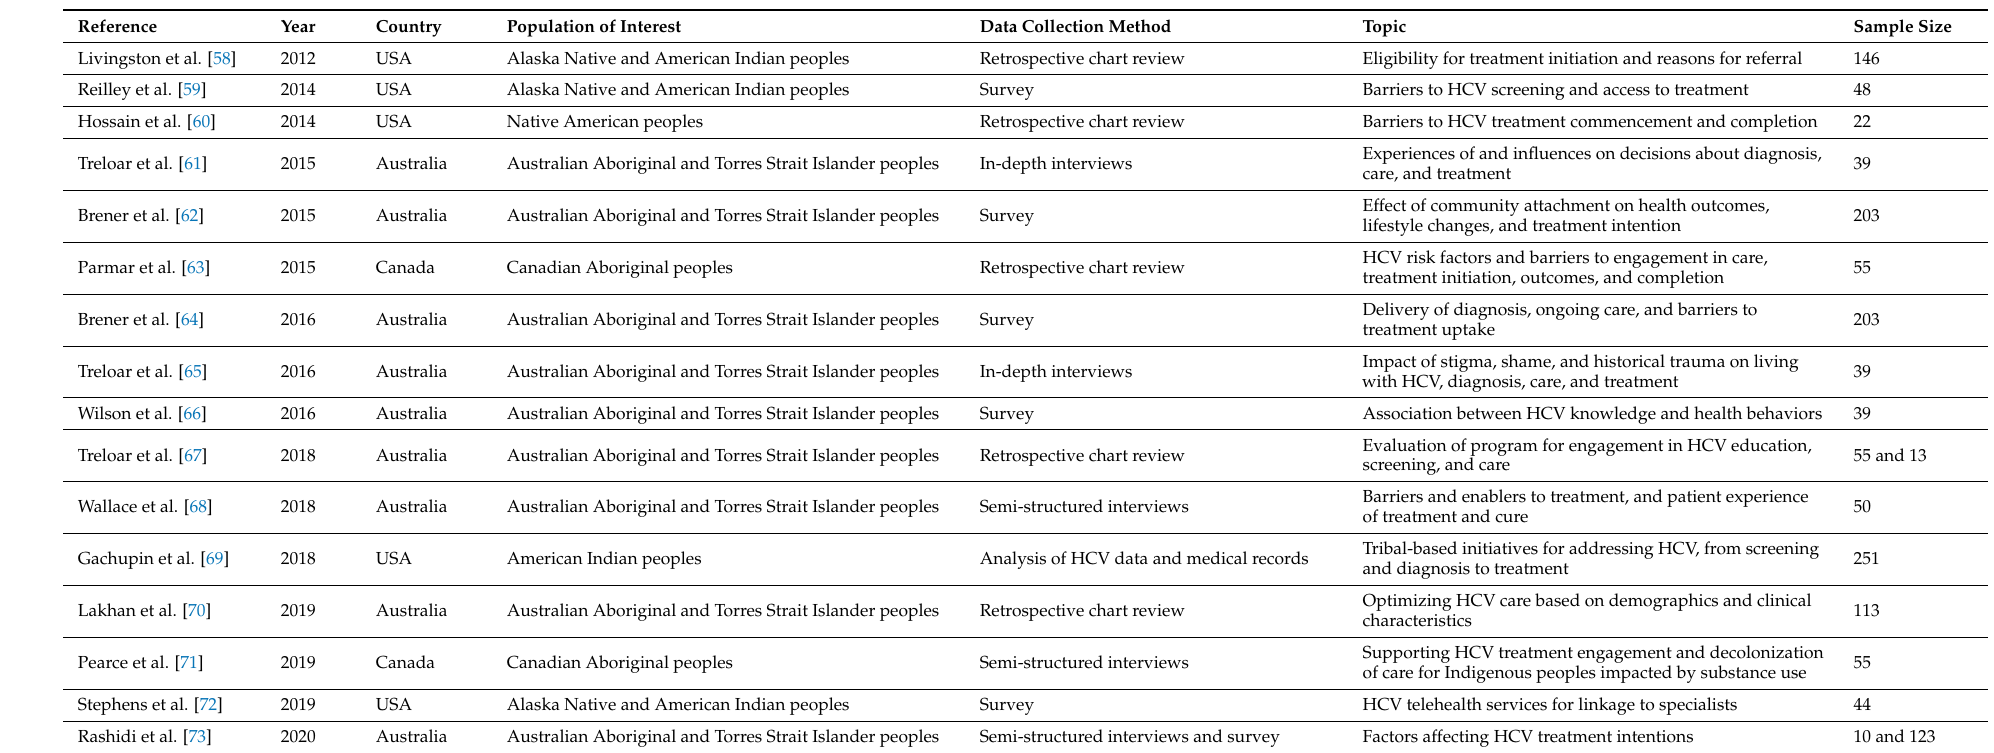
Table 1. Included papers in the systematic